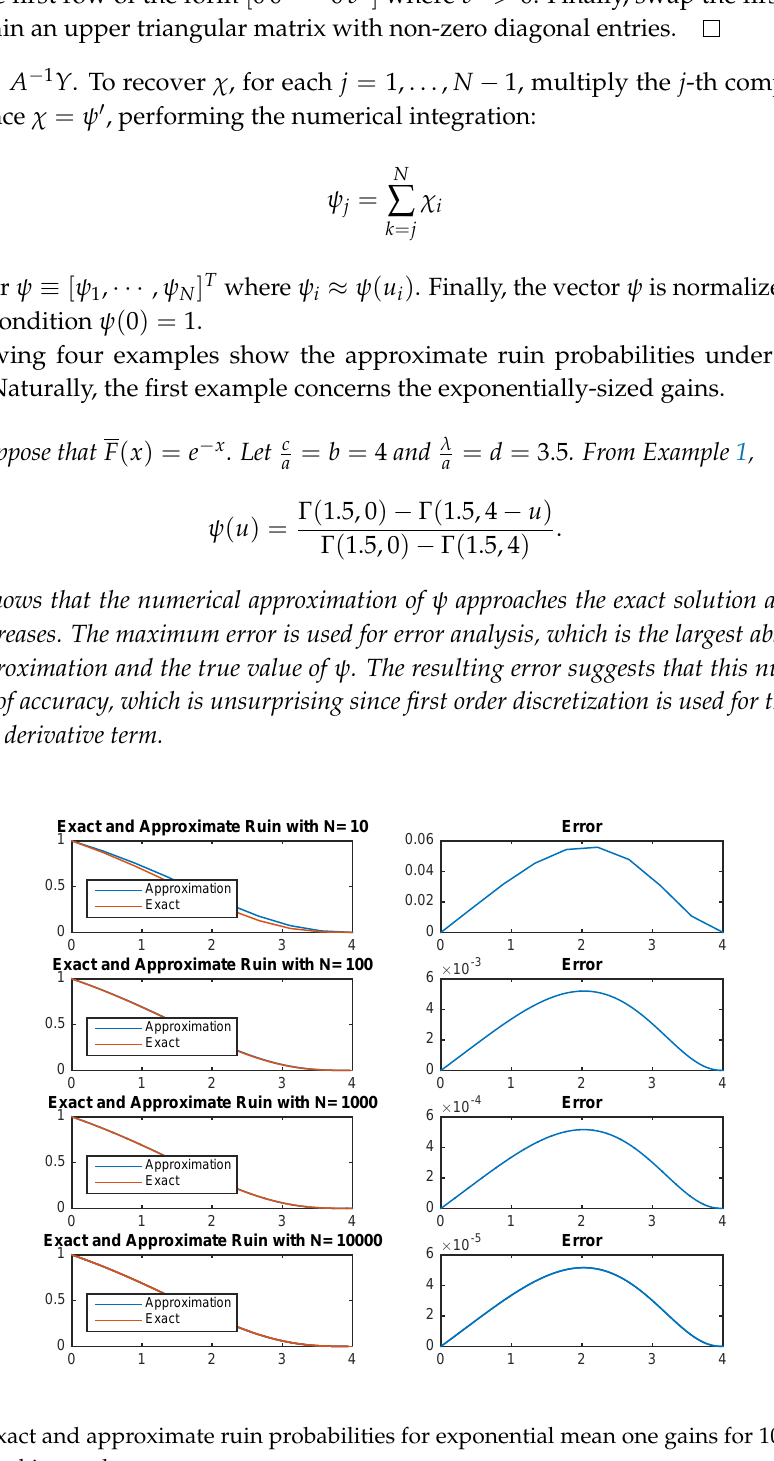
Figure 1. Exact and approximate ruin probabilities for exponential mean one gains for 10, 100, 1000 and 10,000